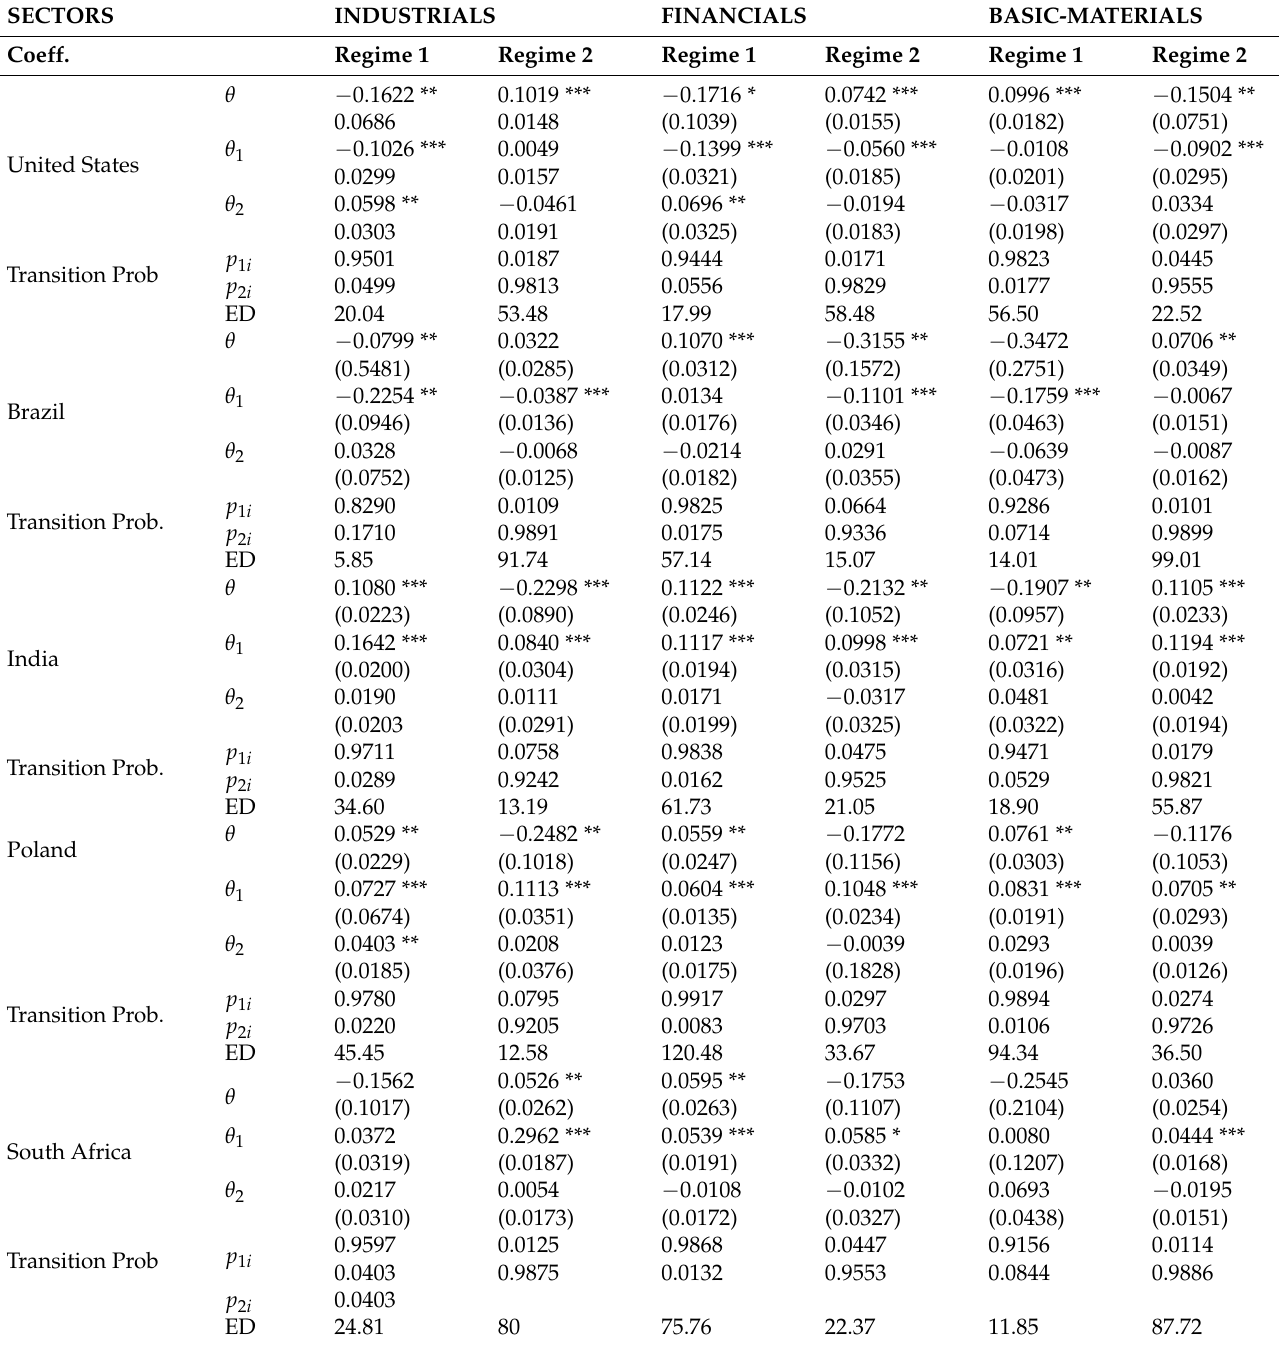
Table A1. Markov Switching estimates’ transition probabilities for equity